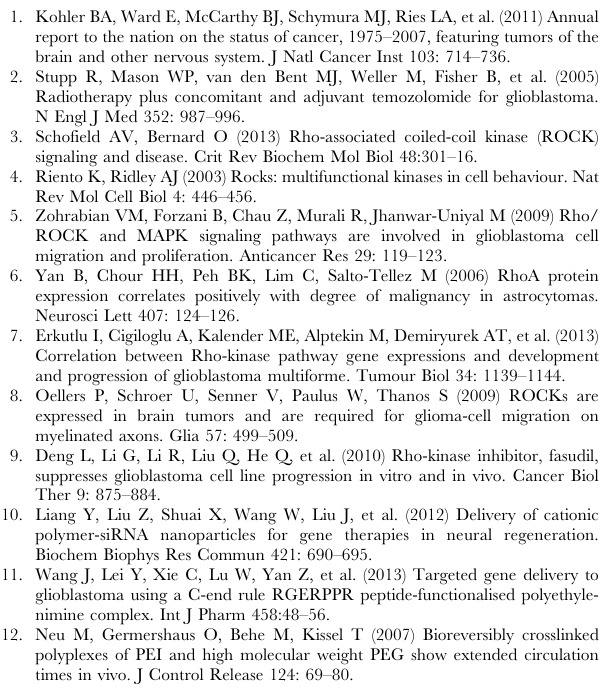
quadrant. a blank group; b siNC group; c siROCK2 group; d TMZ group; e TMZ + siROCK2 group; (TIF) Figure S2 The quantification of the corresponding western blotting bands using the ImageJ software. The data are presented as the (Means 6 SD; n= 3). * P , 0.05 compared with the blank; # P , 0.05 compared with siROCK2 or TMZ. (TIF) Figure S3 The quantification of q-PCR assay (Bax, Bcl- 2, MMP-2 and MMP-9) using the 2 2 DD Ct method. The data are presented as the (Means 6 SD; n= 3). * P , 0.05 compared with TMZ + siROCK2.